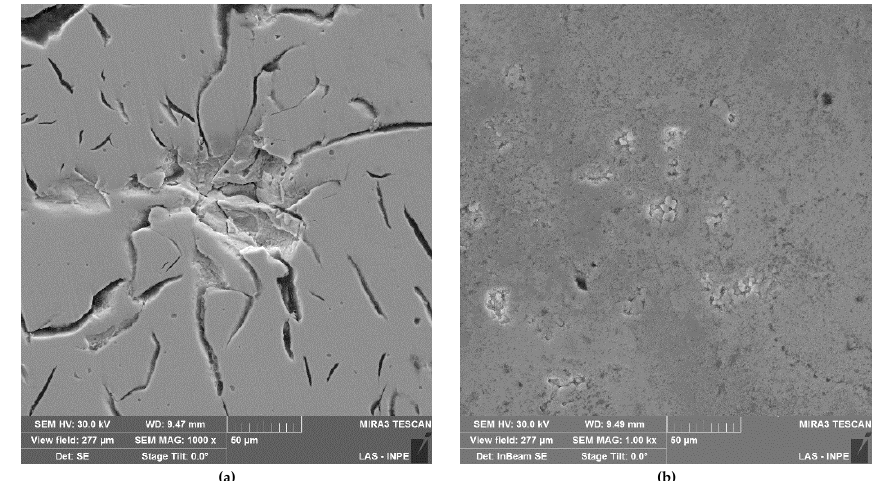
Figure 3. SEM–FEG micrograph on the surface exposed to palm biodiesel at 1320 h. ( a ) Gray cast iron and ( b ) VC coating.